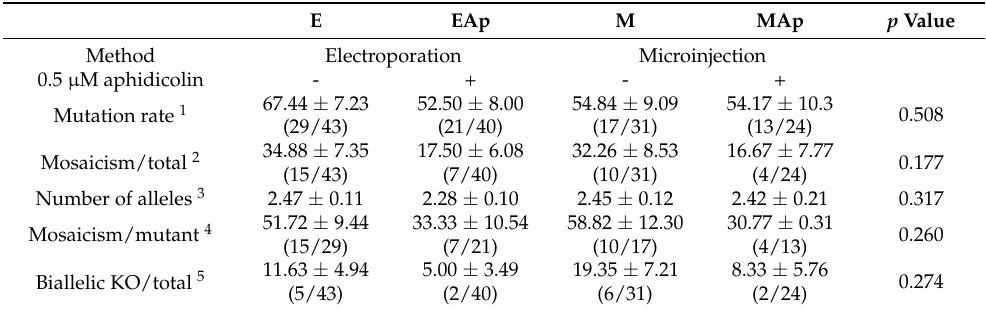
Table 4. Effect of aphidicolin and methodology on mutation parameters expressed as mean ±